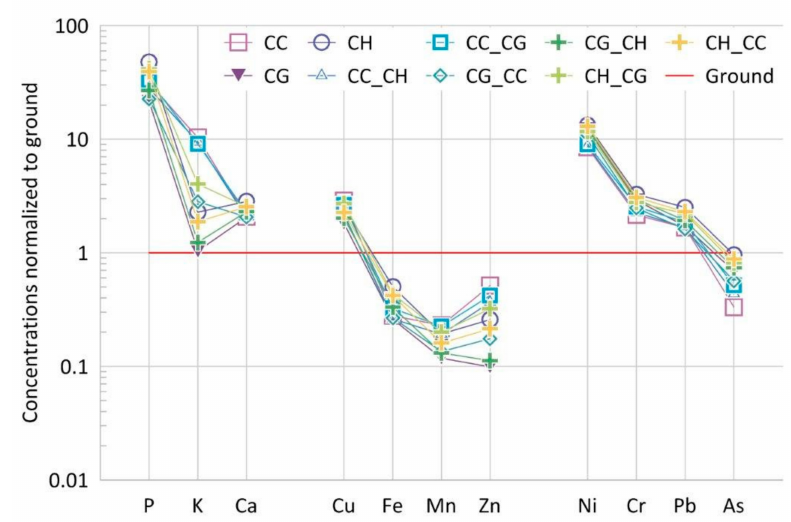
Figure 5. Average elements concentrations in the ashes of the materials tested standardized to their average soil